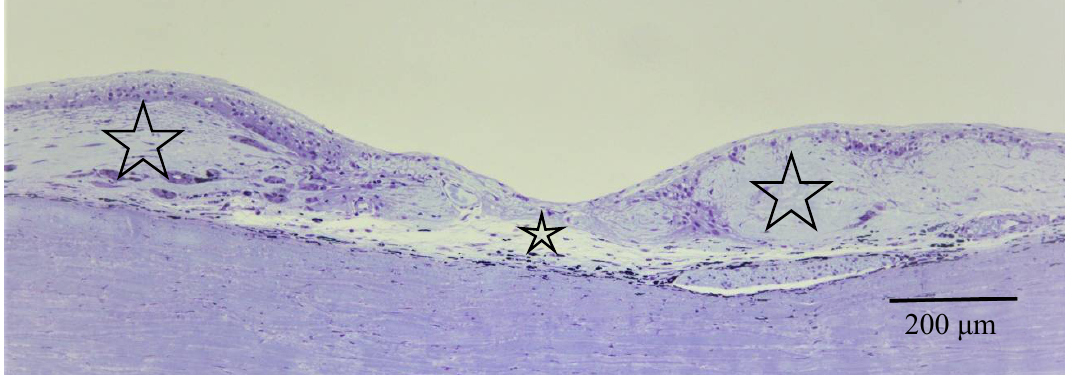
Figure 10. ( A , B ) Light microscopy photographs of the optic nerve in the right eye of Autopsy Case 1, a 75-year-old female with a max IOP of 26 mmHg (Epon embedding, toluidine blue stain). Image B is a higher magnification of the boxed area in A . The location of the optic nerve was 2 mm from the optic nerve head. The nerve fiber bundles were replaced by fibrotic tissue (stars in A ). Granuloma (Gr in B ) was found close to the pia mater (boxed area in A ). Infiltration of lymphocytes were observed adjacent to blood vessel (arrow in B ).